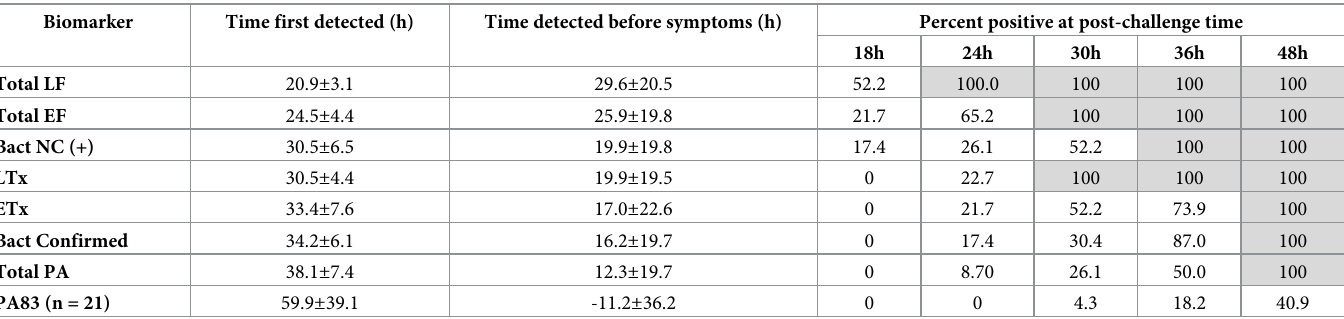
Table 3. Pre-symptom onset